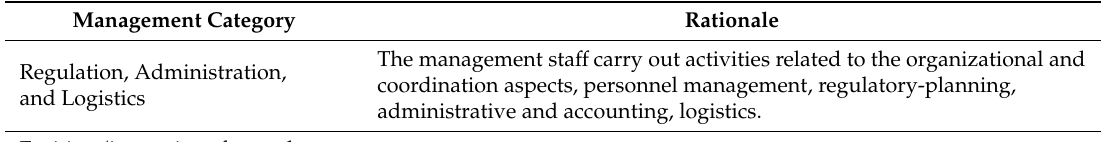
Table 1. List of (ordinary) management actions carried out in the “Torre Flavia” nature reserve (Special Protection Area). For each activity, a short description is